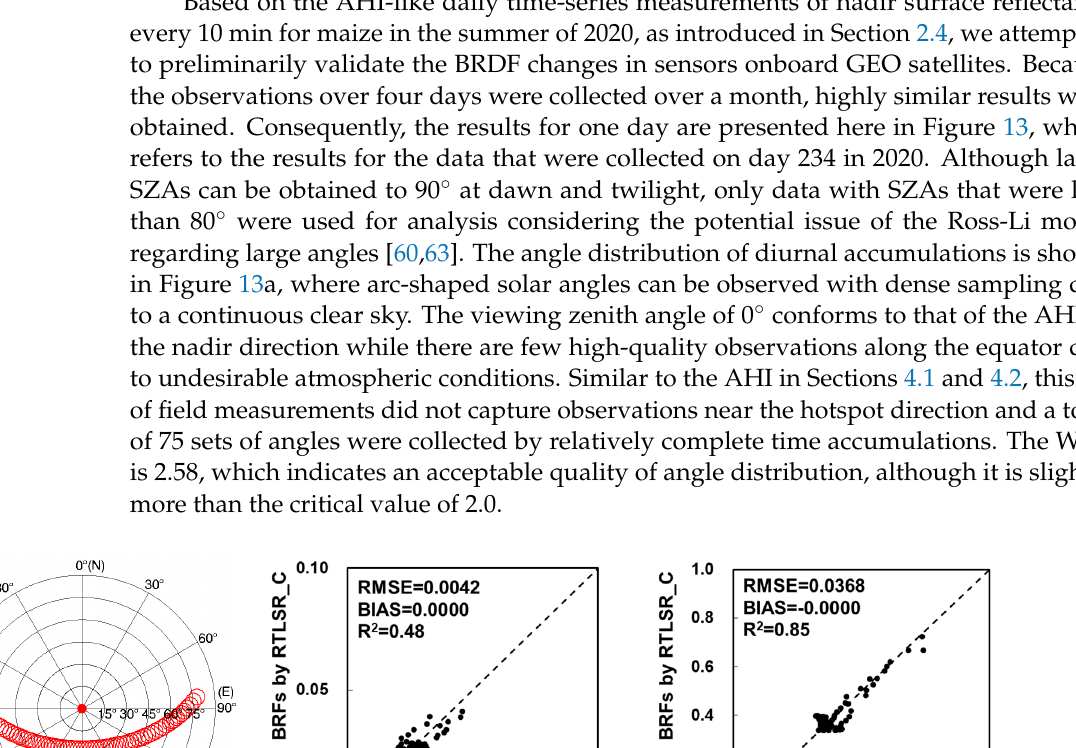
Table 10. Discrepancies in the retrieved albedos between daily, half-month, and monthly accumulated high-quality AHI observations (number ≥ 7, WoD ≤ 2).